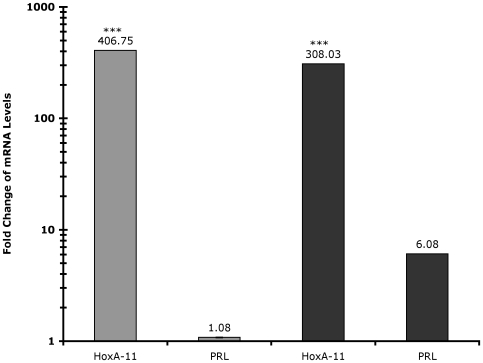
Effect of HoxA-11 overexpression on PRL expression.The expression of PRL mRNA was assayed after overexpression of HoxA-11 in undifferentiated (light gray bars) and differentiated (dark gray bars) ESC. Results are shown as fold changes relative to PRL expression in undifferentiated and differentiated mock-transfected cells, respectively. HoxA-11 expression was confirmed in undifferentiated (light gray bars) and differentiated (dark gray bars) ESC. HoxA-11 enhanced upregulation of PRL only in differentiated cells. Note, the y-axis (fold change) is log-scale. n = 6 replicate experiments, means±SEM. ***, P<0.001 (t-test, overexpression compared to undifferentiated and differentiated, respectively).